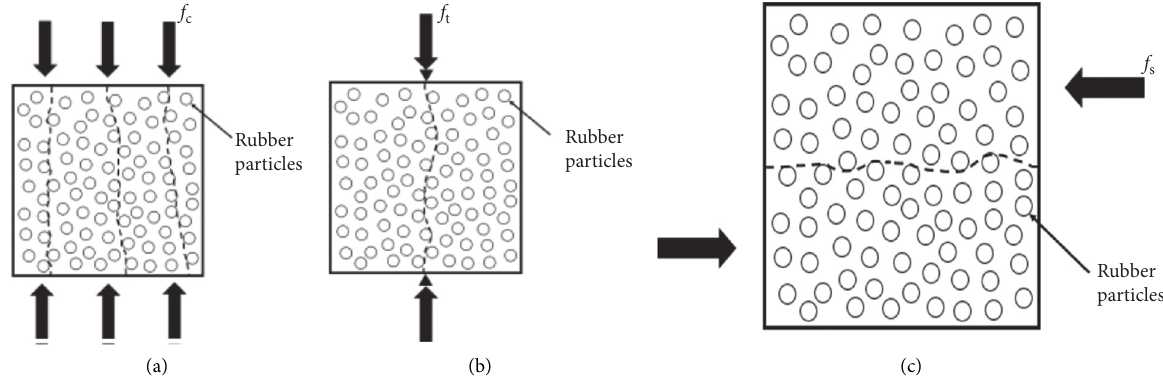
Figure 13: Failure mechanisms of rubber concrete under different loading modes. (a) uniaxial compression, (b) uniaxial tension, and (c) pure